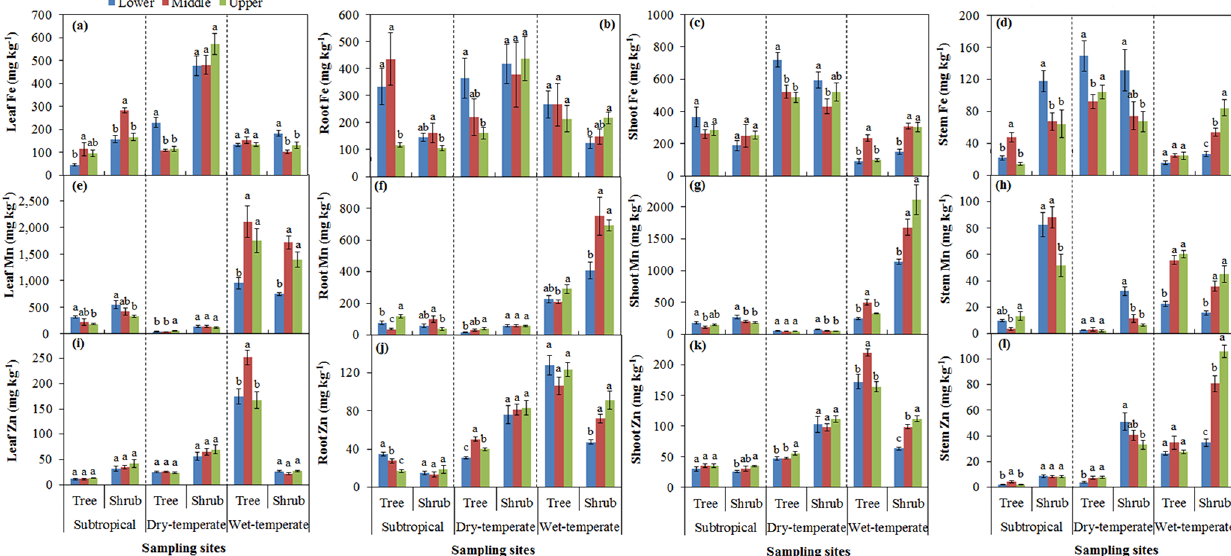
Figure 4. Micronutrient concentrations of Fe (a, b, c, d) , Mn (e, f, g, h) , and Zn (i, j, k, l) in plant tissues of leaf, root, shoot, and stem sapwood at lower and middle elevations as well as at the upper limit of trees and shrubs for each of the three sites. Different letters indicate significant differences among three elevations within tree and shrub lines for each